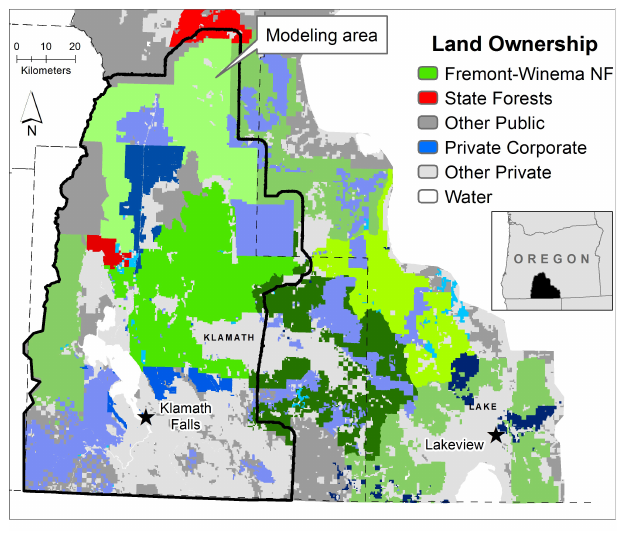
Fig. 1. The study area in southcentral Oregon, with land ownership. Different shades of green represent different districts of the Fremont-Winema National Forest. Different shades of blue represent different private corporate ownerships.